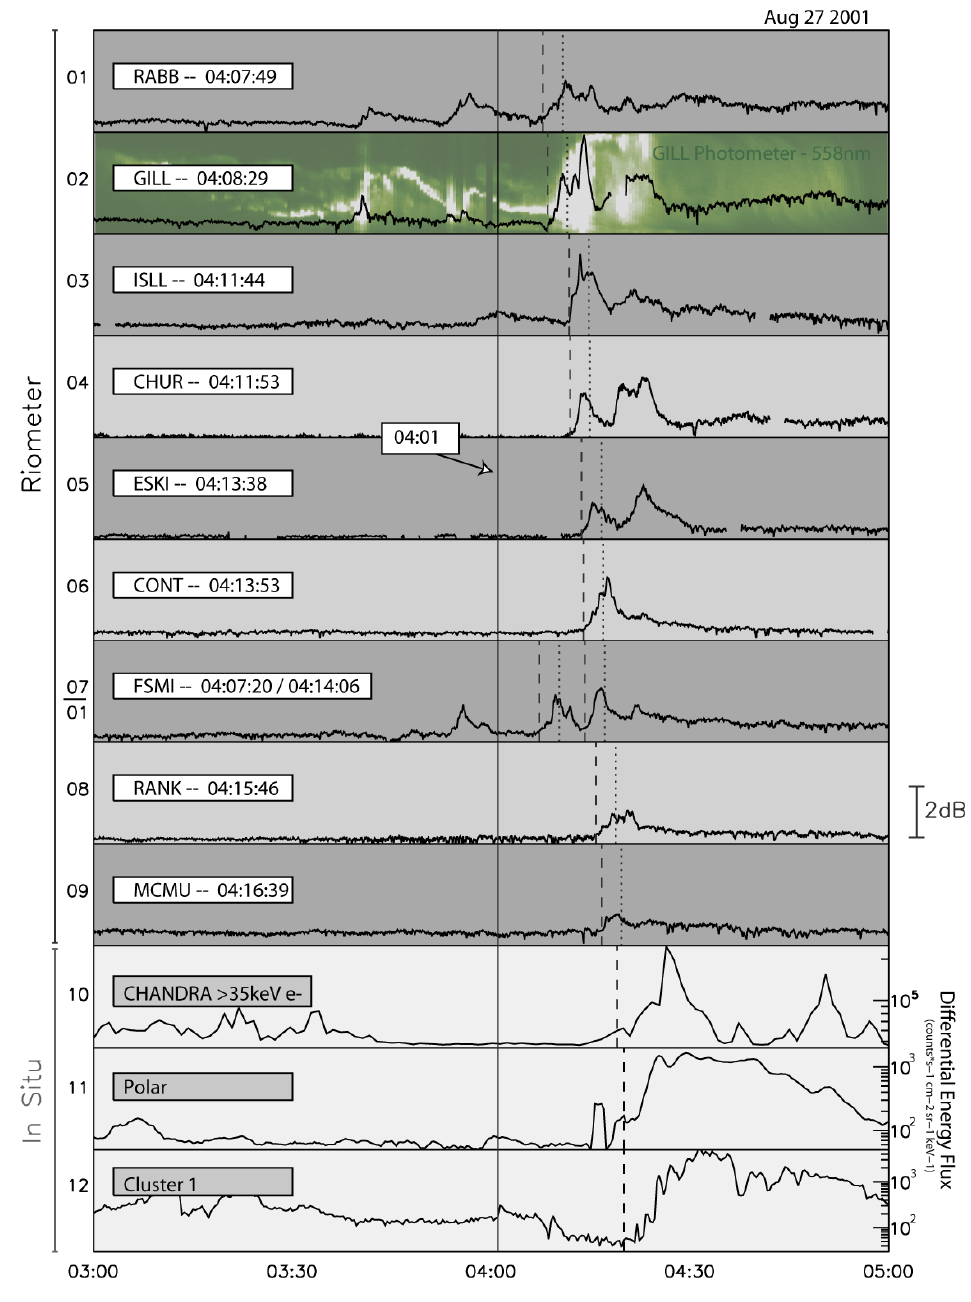
Figure 2. Data and onset times for the 12 point observations of the dispersionless electron injection on 27 August 2001. Panels are plotted in order of onset time, with the earliest onset shown at the top. Panels 1–9 are riometer absorption (in dB) from CGSM riometers, an increase in absorption is a positive deviation of the line. Gillam Meridian Scanning Photometer data from the 557.7nm channel is shown in the background of panel 2. High-energy electron measurements from Chandra, Polar and Cluster 1 are shown in panels 10, 11, and 12,